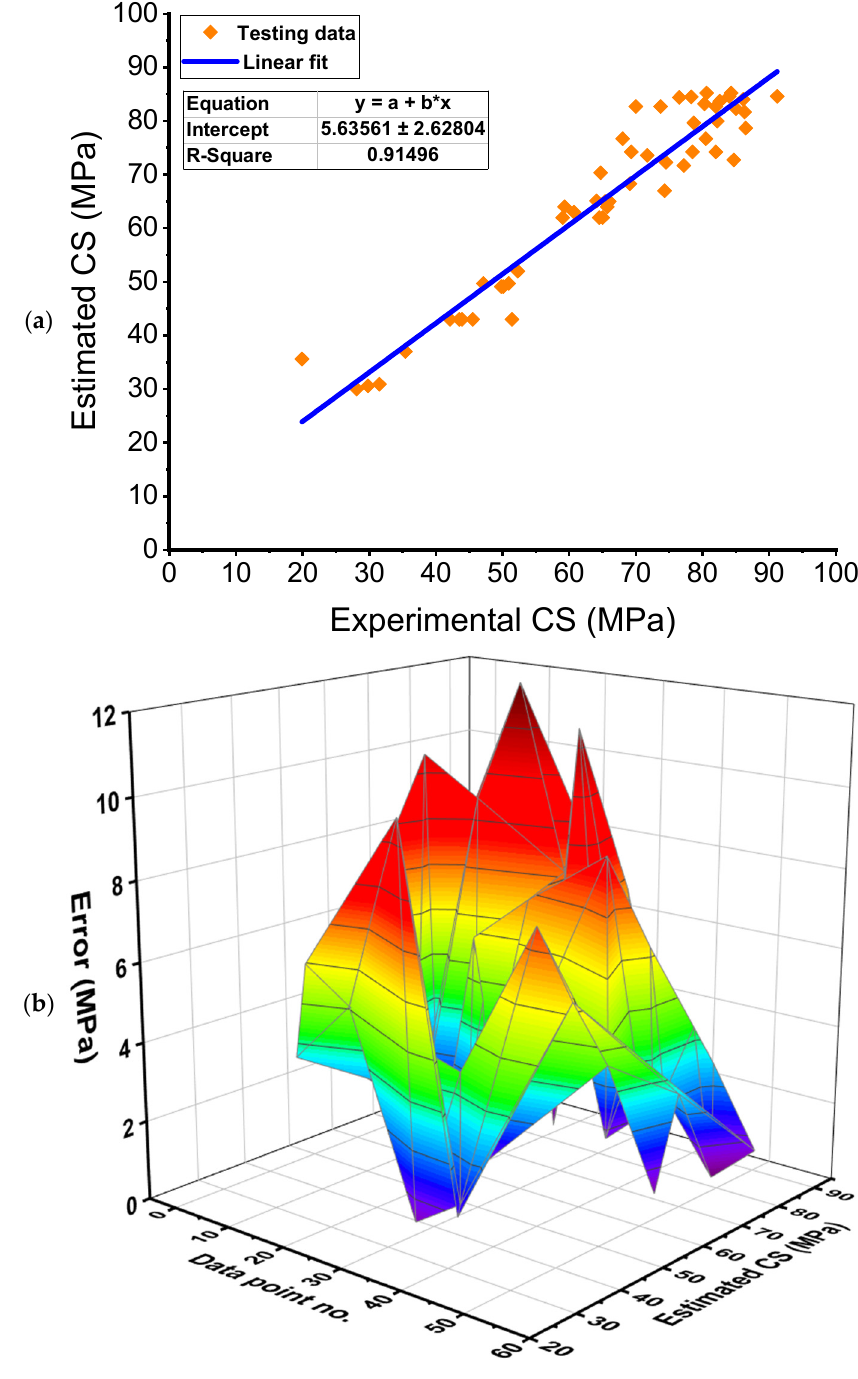
Figure 10. AdaBoost regressor model: ( a ) Relation between real and anticipated outcomes; ( b ) Dis- persion of anticipated results and errors. 𝐸𝑟𝑟𝑜𝑟 = |𝐸𝑥𝑝𝑒𝑟𝑖𝑚𝑒𝑛𝑡𝑎𝑙 𝑟𝑒𝑠𝑢𝑙𝑡 − 𝐸𝑠𝑡𝑖𝑚𝑎𝑡𝑒𝑑 𝑟𝑒𝑠𝑢𝑙𝑡|.